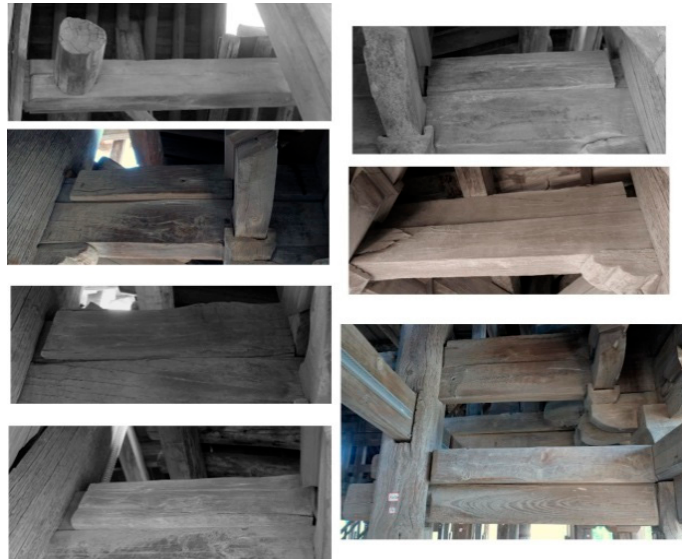
Figure 2. Joint damages.